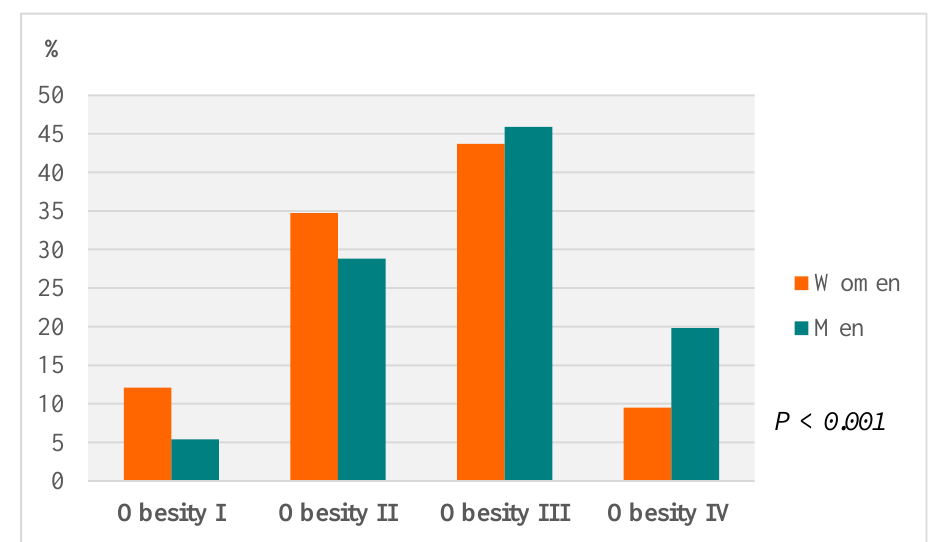
Figure 1. Distribution of patients by classification criteria according to BMI and gender at initial consultation (Obesity I = BMI 30–34.9; Obesity II = BMI 35–39.9; Obesity III = BMI 40–49.9; Obesity IV = BMI > 50).